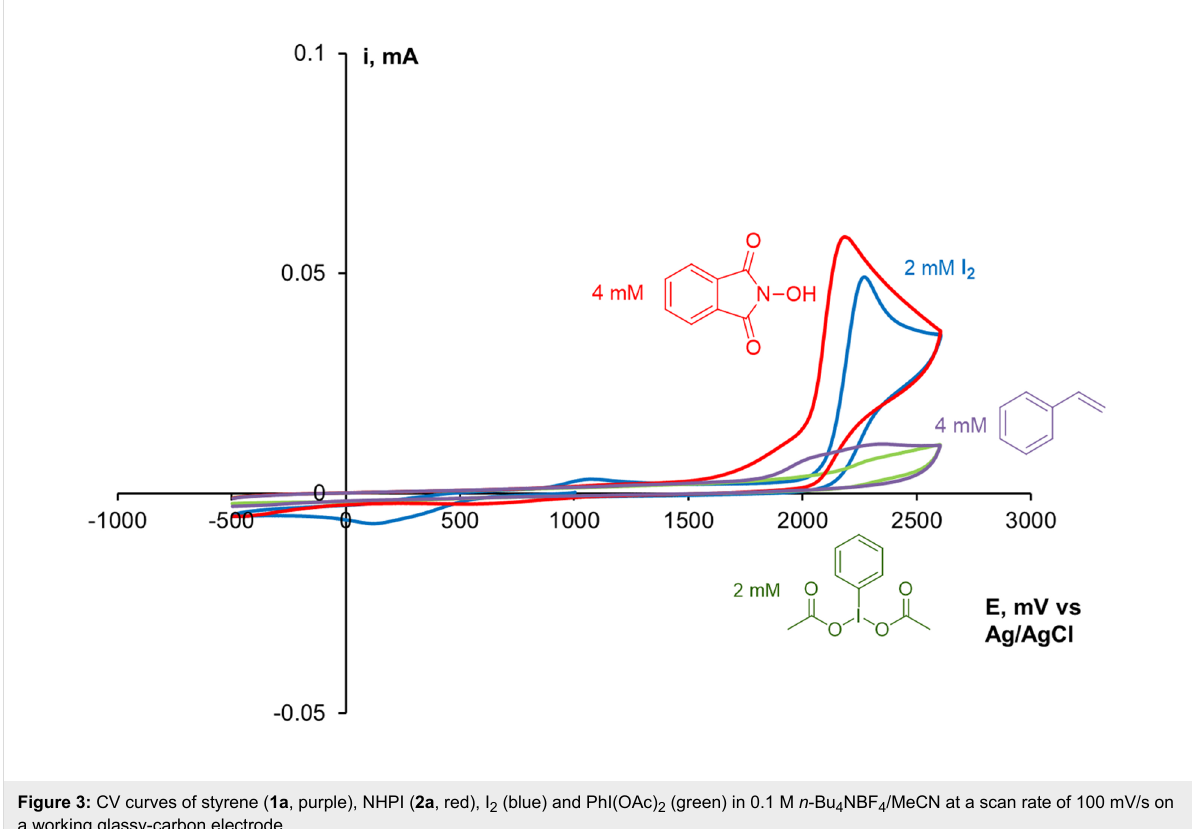
Figure 3: CV curves of styrene ( 1a , purple), NHPI ( 2a , red), I 2 (blue) and PhI(OAc) 2 (green) in 0.1 M n -Bu 4 NBF 4 /MeCN at a scan rate of 100 mV/s on a working glassy-carbon electrode.